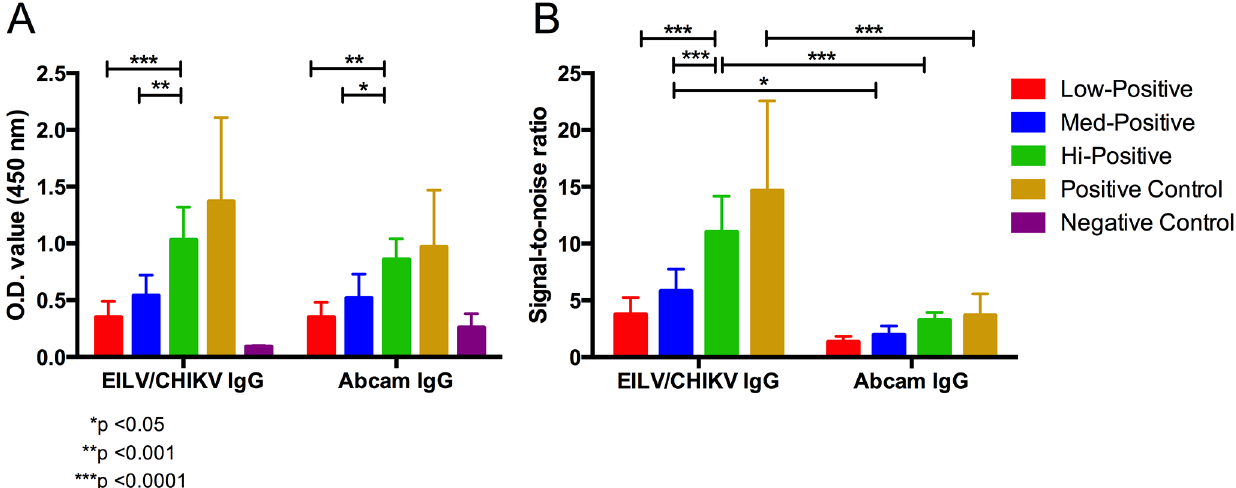
Fig 4. Comparison of EILV/CHIKV and Abcam human anti-CHIKV IgG-capture ELISA methods. (A) raw OD values or (B) signal-to-noise ratios (calculated by dividing positive sample OD values by mean negative control OD value) produced by samples of varying degrees of seropositivity were compared. Low-positive samples had PRNT 80 (cid:1) 80 (n = 10), medium-positive samples had PRNT 80 160 – 320 (n = 10), and high-positive samples had PRNT 80 > 640 (n = 10). Means and standard deviations are reported. A 2-way ANOVA with Tukey ’ s test was used to compare absorbance values and signal- to-noise ratios within each ELISA method. 2-way ANOVA with Bonferroni ’ s test was used to compare absorbance values and signal-to-noise ratios between each ELISA method.